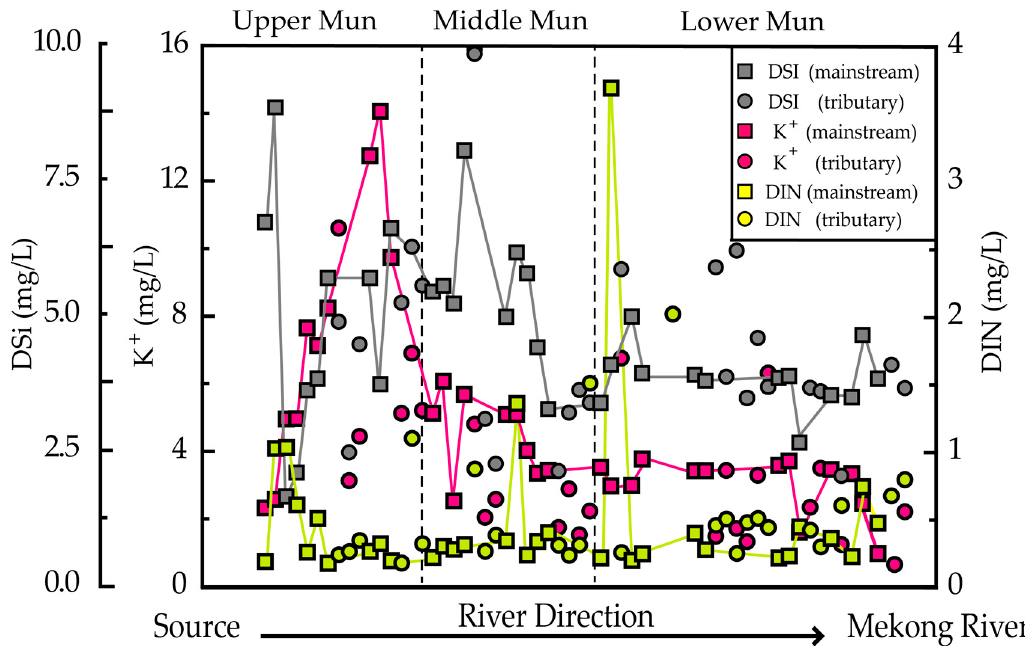
Figure 4. Evolution of contents of K + , DSi, and DIN from the upper to the lower